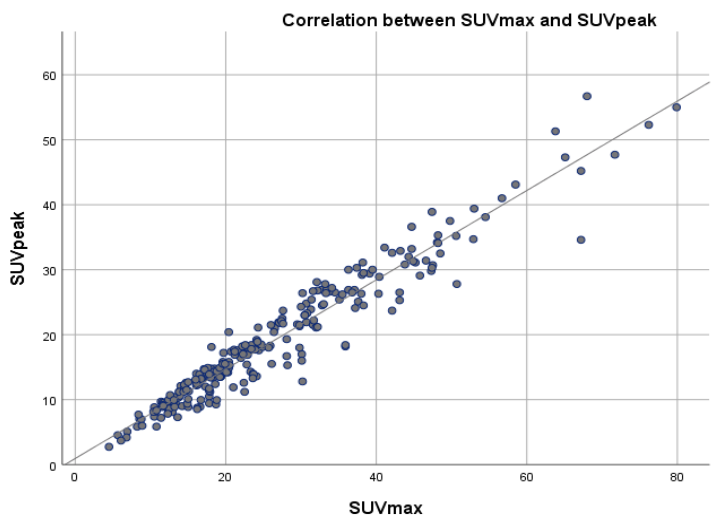
Figure 7. Scatter plot showing the correlation between SUVmax and SUVpeak values across a reference line.